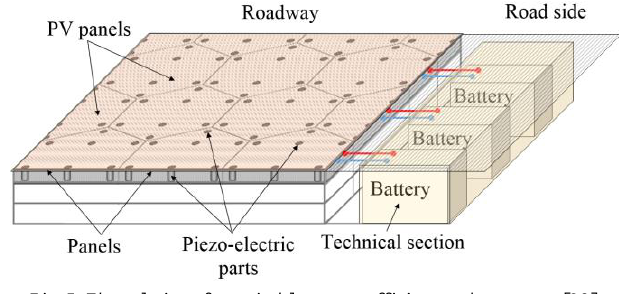
Fig. 5. The solution of sustainable energy efficient road pavement